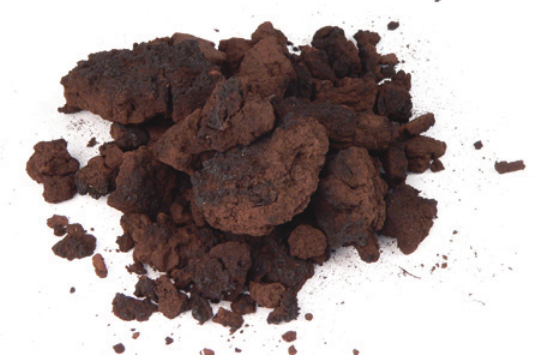
Figure 6: Biogenous residues can be processed to biocoal by hydrothermal carbonization. © Fraunhofer UMSICHT.